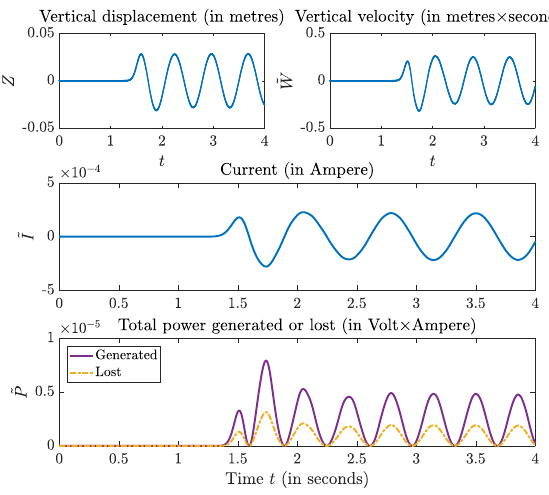
Fig. 5. Output of the numerical simulation demonstrating the response of the wave-energy device to the incoming waves (panels on top row; left: vertical displacement, right: velocity). The energy generated is also shown in terms of current (middle panel) and power (bottom panel). The power output depicted in the bottom panel is divided into two parts: the power output to the LEDs (solid purple line) and the power lost in the electrical circuit (dash-dotted yellow line).